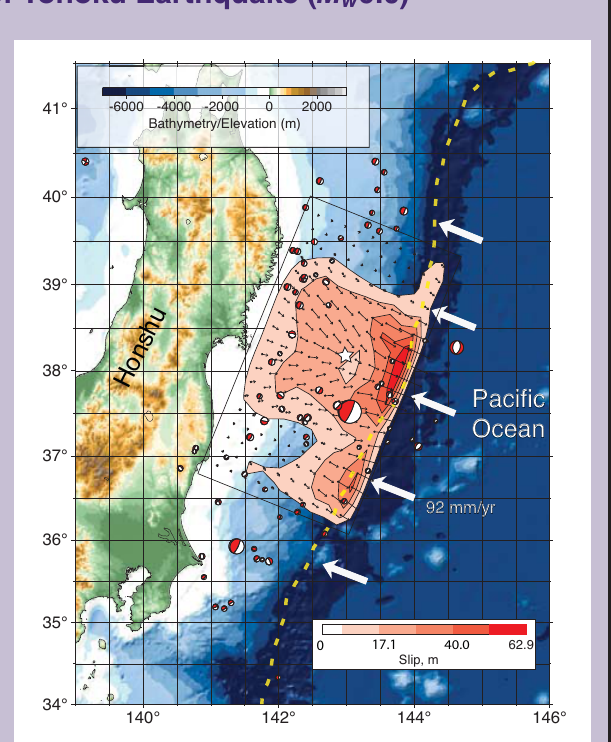
Figure 1. Teleseismic P-wave inversion for slip (Lay et al., 2011). Maximum slip ranges from 40–80 for a suite of inversion models with the majority of models placing large slip near the trench. Most models do not directly incorporate the ocean bottom observations in Figure 2 and 11 which require large slip towards the updip end of the rupture.